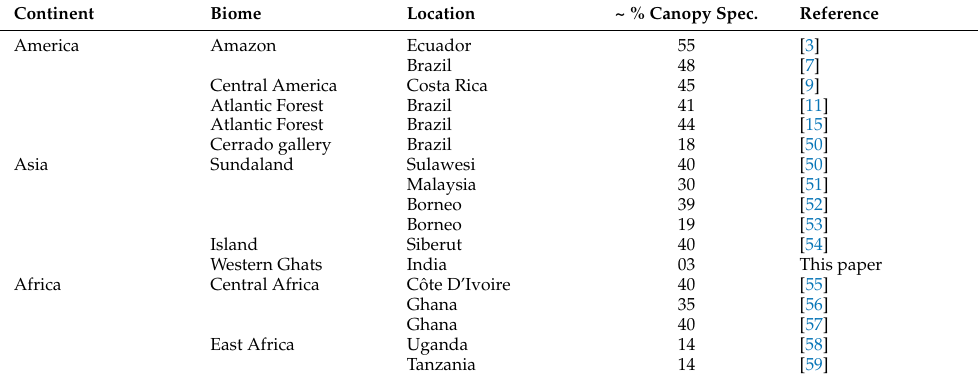
Table 3. Vertical stratification of fruit-feeding butterflies in (relatively undisturbed) tropical forests as extracted from the literature [3,7,9,11,15,50–59]. Note that the % canopy species that we calculated from the reported data will depend on sampling effort and butterfly abundance, and studies vary in their use of trap heights. Within each continent, we distinguish biomes that are large forest blocks (highlighted in gray) and outlying biomes. There appears to be a lower proportion of fruit-feeding butterflies that is specialized in the canopy in more outlying rainforests. Continent Biome Location ~ % Canopy Spec. Reference